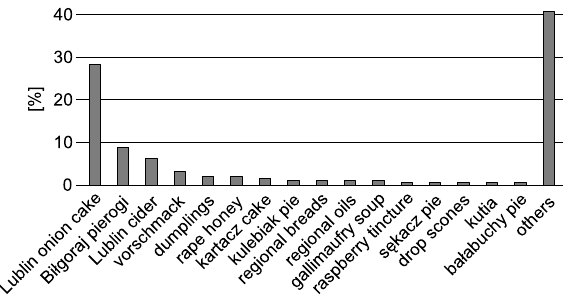
Fig. 6. Dishes and regional products mentioned by the